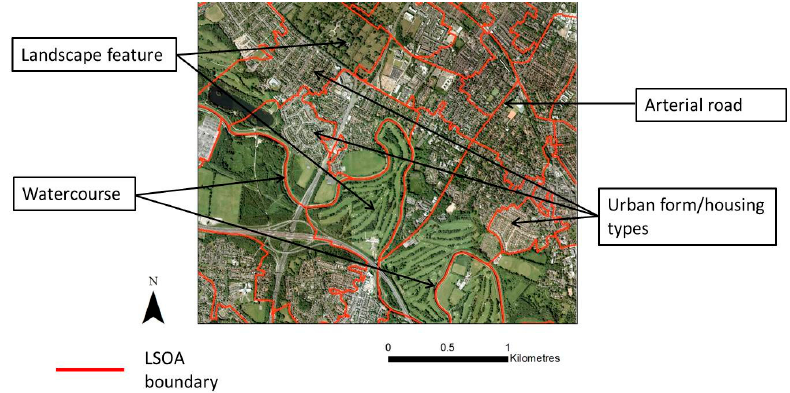
Figure 3. Boundaries of socio-geographic statistical units (Lower Super Output Areas) in South Manchester, UK. Source: Boundary data, ONS (2011); Aerial imagery, Edina (2017).